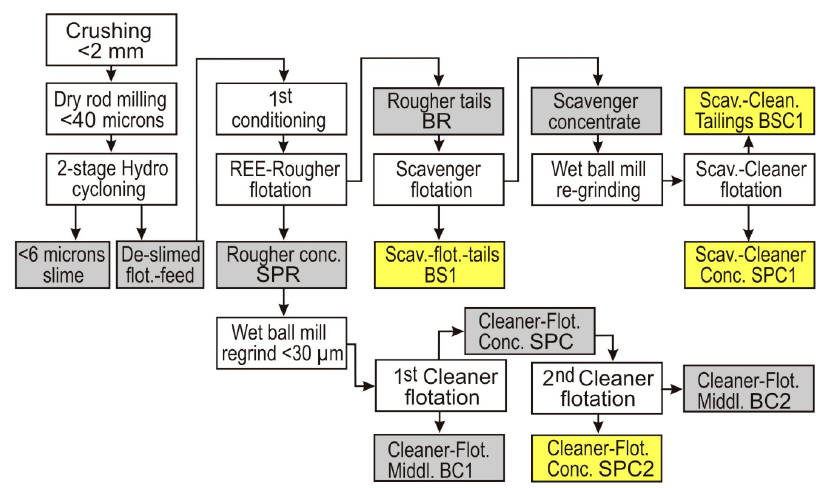
Figure 4. Flow scheme of multi-stage open cycle flotation tests with REE carbonatite ore, containing monazite and bastnaesite as principal REE minerals. Positions of analysed samples along the flow scheme are marked in yellow, flotation products which are not analysed are marked in grey.